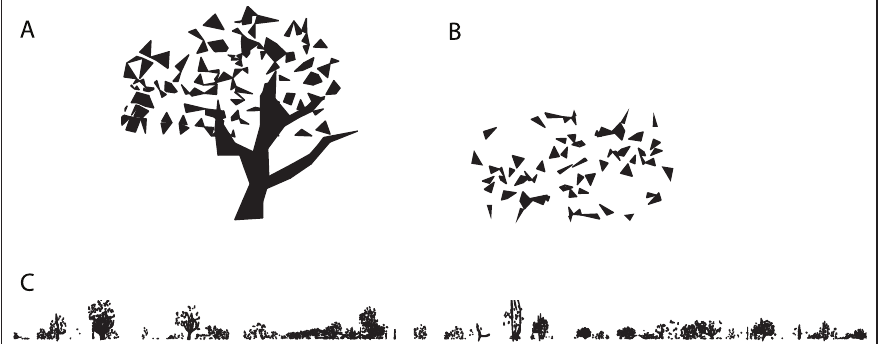
Figure 10. Trees, bushes and the distant panorama. A) Randomly generated tree. B) Randomly generated bush. C) Randomly generated distant panorama.